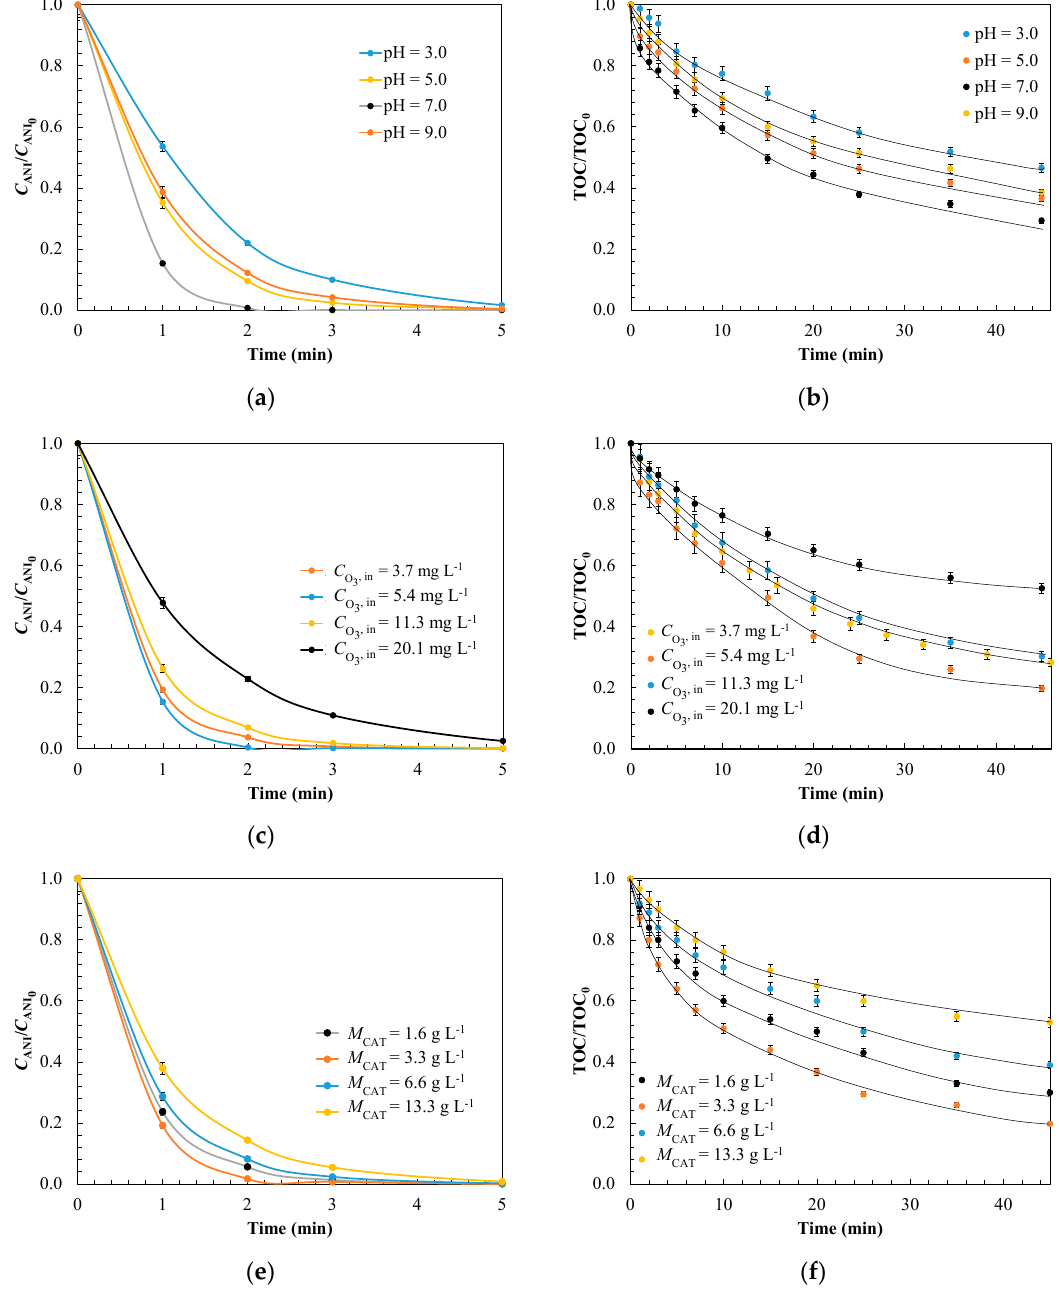
Figure 3. Effect of operating conditions on catalytic ozonation with TiO 2 /GAC: ( a ) pH 1 , ( c ) inlet ozone concentration 2 , and ( e ) mass of TiO 2 /GAC catalyst in the aniline removal and ( b ) 1 , ( d ) 2 and ( f ) in TOC (mineralization), showing experimental and modelled profiles fitted to the Ad/Ox process 3 . Experimental conditions: Q G = 4 L min − 1 ; T = 18.0 °C; P = 1 atm; V reac = 1.5 L; ( Agitation ) = 60 rpm. 1 C O 3,in